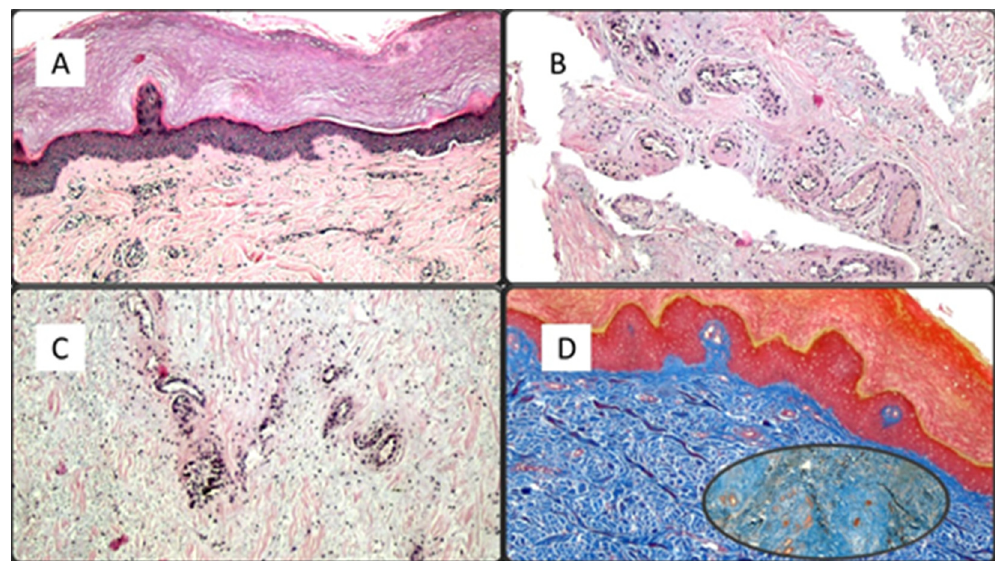
Figure 6. ( A ) Histological preparation demonstrating mild ortho-parakeratosis, focal vacuolation of the keratinocytes of the basal layer and mild inflammatory infiltration of the superficial dermis (Hematoxylin-Eosin, 4 ×); ( B , C ) Histological details of the superficial capillary plexus vessels characterized by swollen endothelial cells, of the “hobnail” type, with a narrow lumen and focal thrombotic phenomena (Hematoxylin-Eosin, 10 × and 40 ×); ( D ) Masson’s trichrome stain which highlights the preservation of collagen fibers in the superficial dermis and their fragmentation at the level of the medial/deep dermis (Masson’s Trichrome stain, Original Magnification: 10 ×, box: 20 ×).